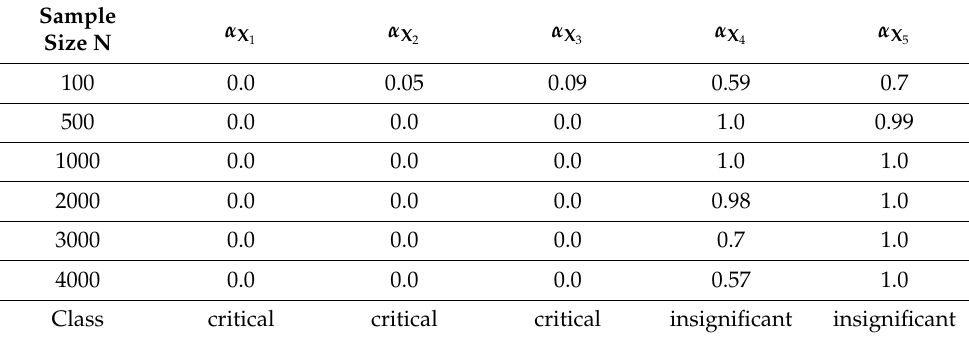
Figure 12. D-stat values versus sample size N. Table 1. Significance level 𝛼 for the different input variables and sample sizes.